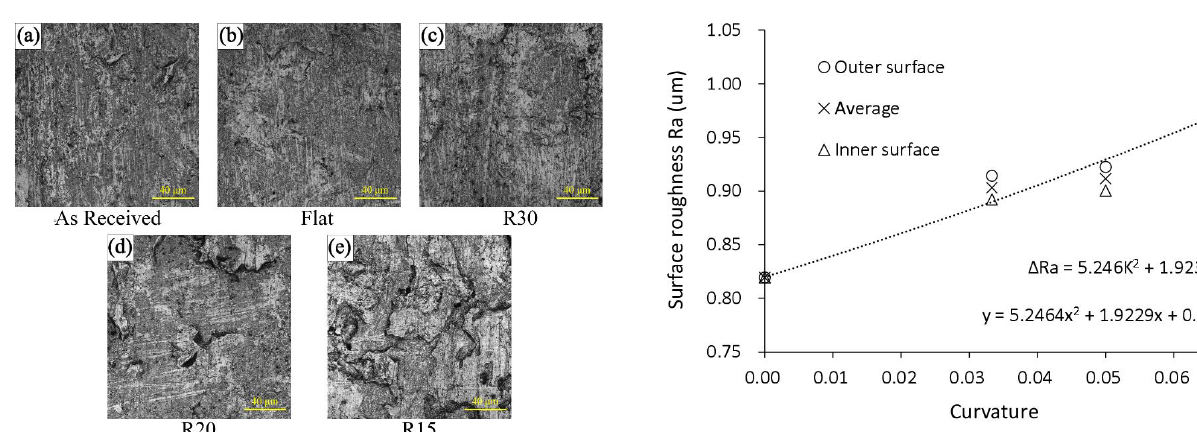
Figure 18. Surface morphology of the as-received sheet and the specimens stamped by flat and curved dies (R30, R20, R15).